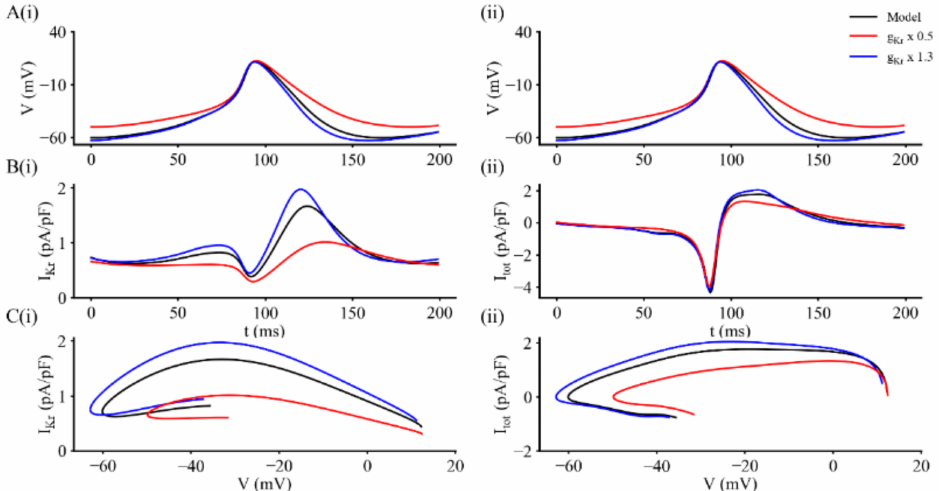
Figure 6. Time course and phase plane plots of I Kr and I tot during a simulated SAN action poten- tial based on our modified mathematical model for this K + current. In these computations, the effects of either a 50% reduction, or a 30% increase in baseline I Kr on the spontaneous membrane action potential (AP) and the net or total ion channel-mediated current (I tot ) during the AP and pacemaker depolarization were computed. Details of the modifications are in the Methods and the Supplement Section. As in Figure 5, Panels A ( i ) and A ( ii ) represent identical or duplicate action potential/pacemaker depolarization records presented in this way so that the timing of the ionic current changes shown below can readily be seen. In each panel the three superimposed traces represent control data (black), data obtained from simulations after the maximal conductance for I Kr was decreased by 50% (red) and data sets corresponding to model output after this conductance had been increased to 130% of its baseline value (blue). Panel B ( i ) shows I Kr records and in Panel B ( ii ) illustrates the net or total transmembrane ionic current (the sum of I Na , I CaL , I Kr and I f ). The plots in Panels C ( i ) and C ( ii ) illustrate our phase plane analyses for I Kr and I tot , respectively. Note that the selected decrease in I Kr prolonged APD and depolarized MDP; in combination, these changes reduced the slope of the pacemaker depolarization and slowed heart rate. Increasing I Kr produced opposite effects on APD, MDP, and heart